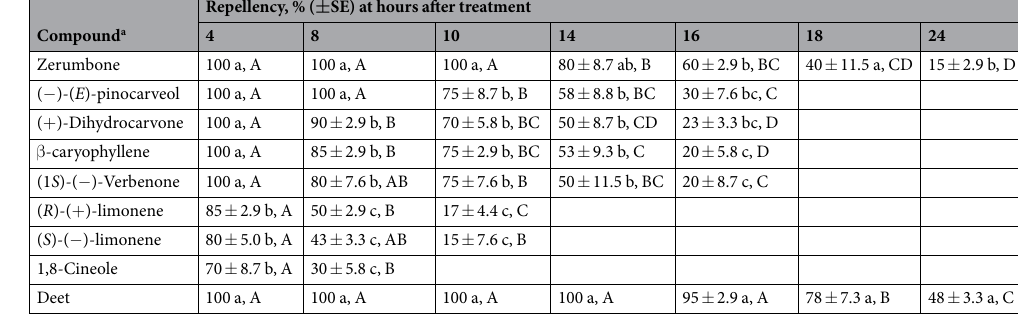
Table 3. Residual repellency of eight selected organic pure compounds and the commercial repellent deet against male Blattella germanica using an Ebeling choice box assay at 652.4 μ g cm − 2 . Means followed by the same lowercase letter in the same column or the same uppercase letter in the same row are not significantly different ( P = 0.05, Bonferroni method).